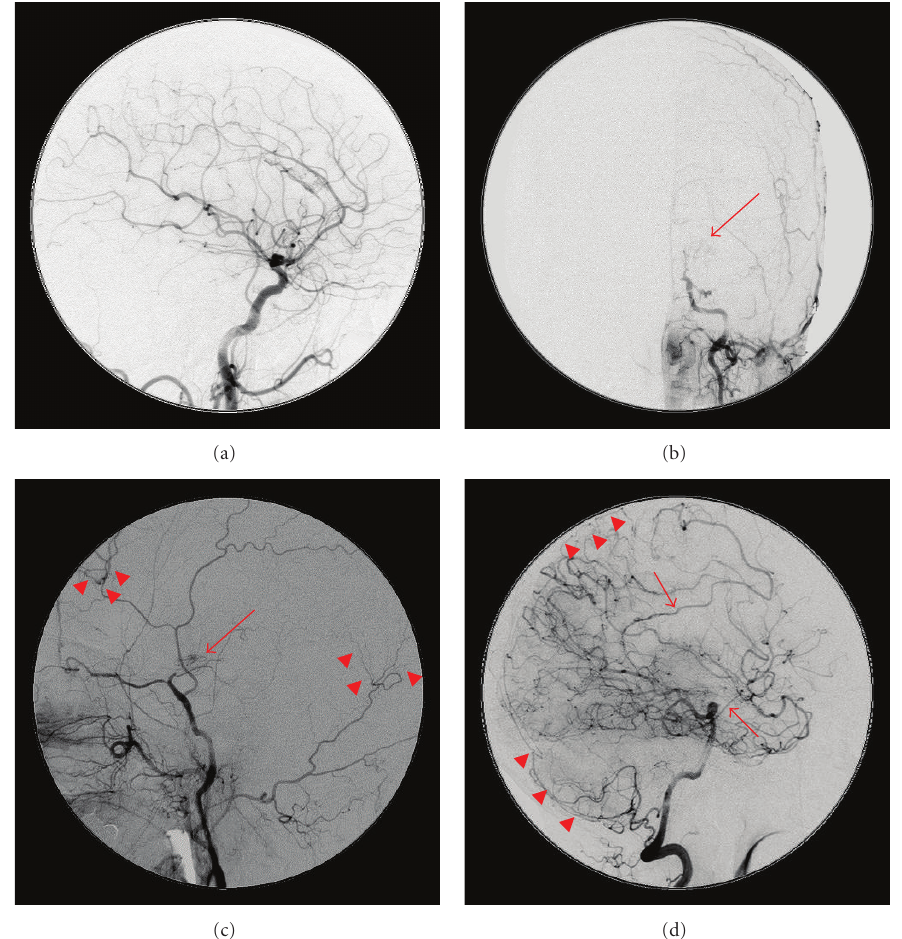
Figure 3: Preoperative head angiograms. Anteroposterior view (b) and lateral view of the left common carotid angiogram (c) indicating occlusion of the left internal carotid artery (ICA) at the C1 segment, leptomeningeal (transdural) anastomosis from the left external carotid artery to the left anterior cerebral artery (ACA) and middle cerebral artery (MCA) area (arrowheads), and formation of basal moyamoya vessels (arrows), and the lateral view of the right carotid angiogram (a) indicating no abnormality. Lateral view of left vertebral angiography (d) showing leptomeningeal anastomosis (arrow heads) and anastomosis to the ACA and MCA area via the left posterior cerebral artery